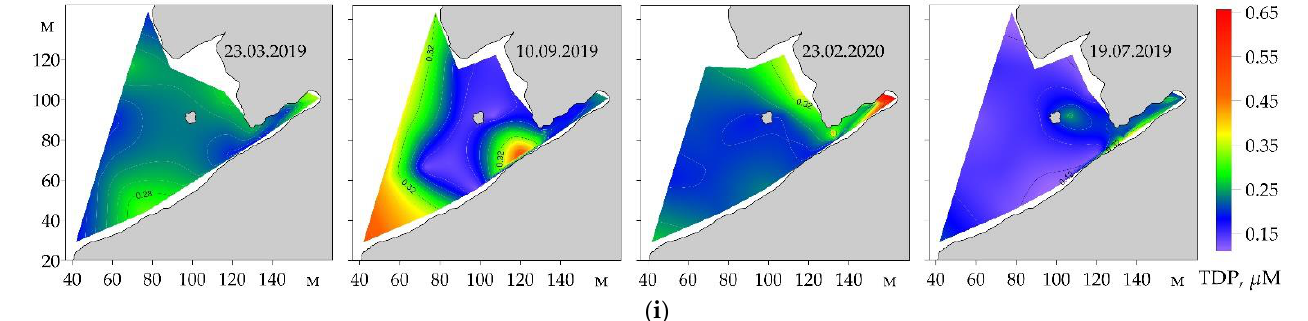
Figure 3. Salinity in the surface layer and at the section of stations 1 – 12 ( a ), concentrations of 226 Ra ( b ), 228 Ra ( c ), silicic acid ( d ), nitrates ( e ), nitrites ( f ), ammonium ( g ), DIP ( h ), and TDP ( i ) in the karst cavity and adjacent stations.